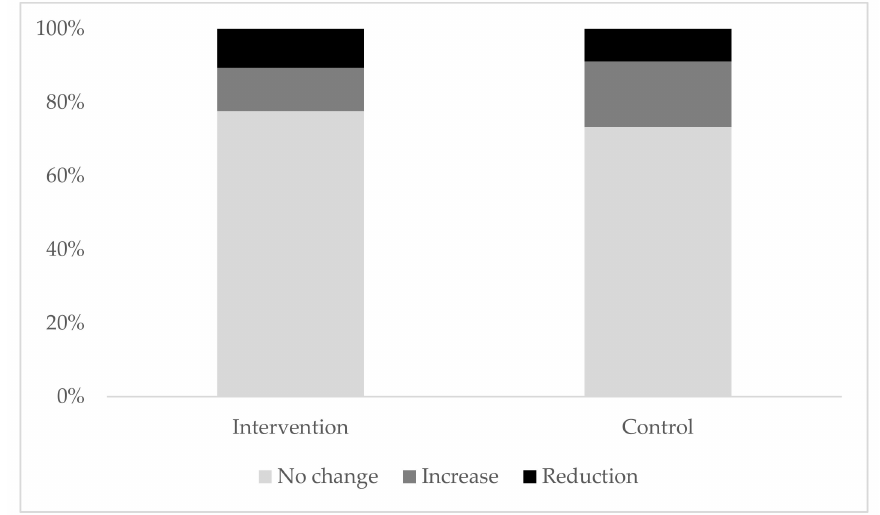
Figure 1. Change in screen time over one year in intervention and control group in